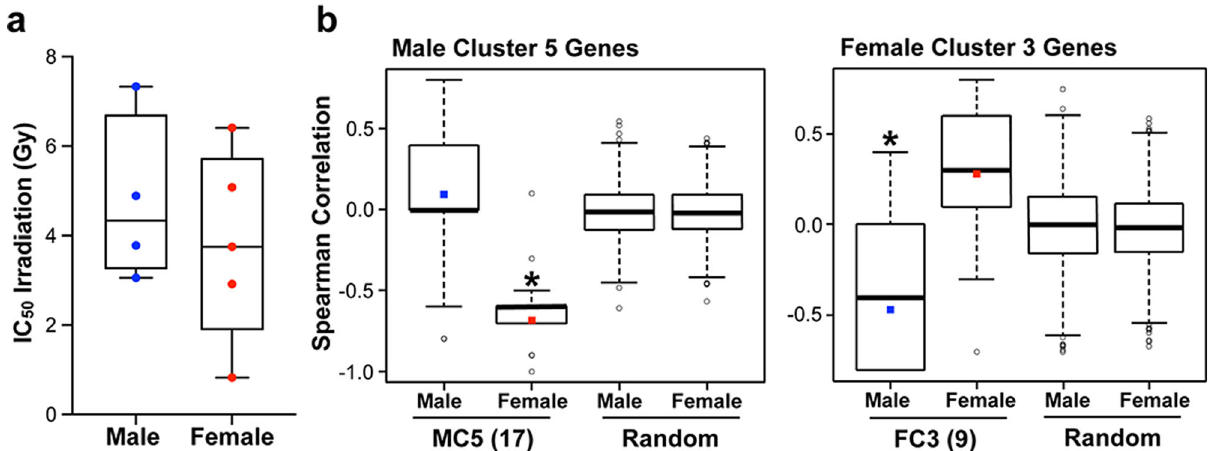
Fig. 1 Unique pathways contribute to cell-intrinsic radiation sensitivity in male and female human GBM lines. a Box plots of irradiation IC 50 values for four male and fi ve female primary human GBM lines (horizontal bar indicates median). b Spearman correlation coef fi cients of irradiation IC 50 values with expression of MC5 genes (17 genes), FC3 genes (9 genes), or random gene sets of the same size. For MC5 and FC3, box plots represent the distribution of the correlation coef fi cients for the 17 and 9 genes respectively. The colored square marks the average. For the random gene sets, the box plots represent the distribution of the Olkin-averaged Spearman correlation coef fi cient for 1000 gene sets of 17 (Male Cluster 5) or 9 (Female Cluster 3) randomly selected genes. MC5: male p = 0.245, female p < 0.001. FC3: male p = 0.025, Female p =